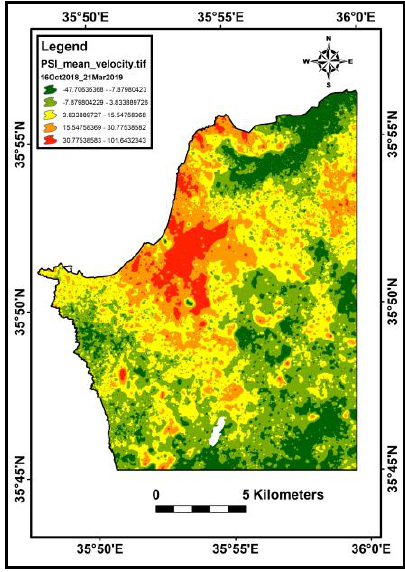
Figure 15. The interpolated mean velocity map of the ground- surface deformation produced using PSI technique.